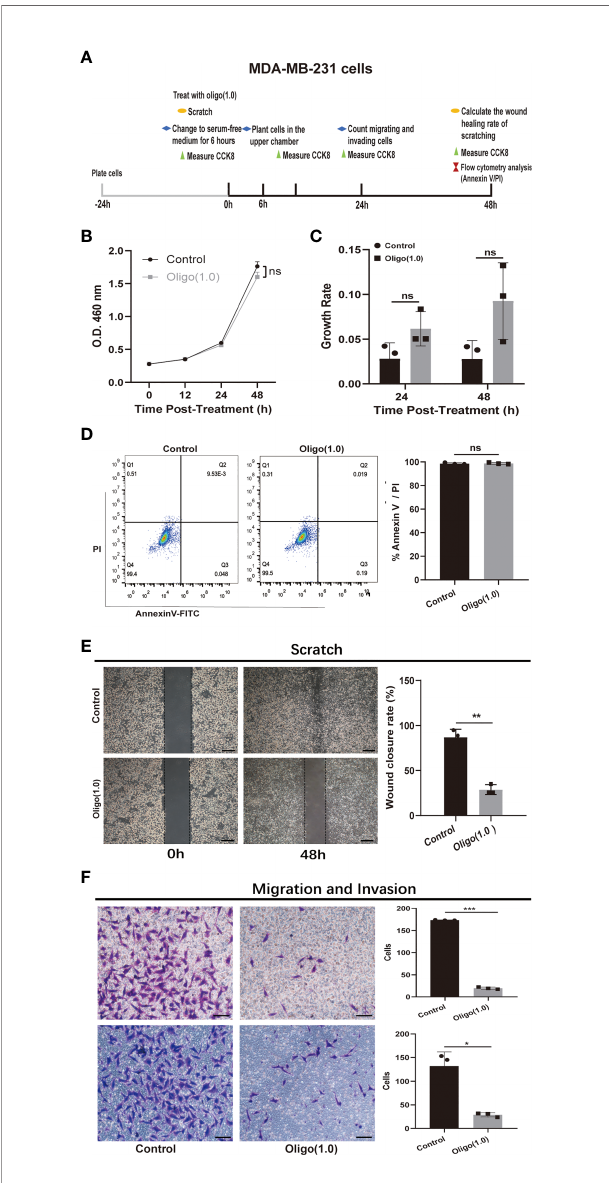
FIGURE 6 | In vitro experiments con fi rmed that OXPHOS plays an important role in breast cancer metastases. (A) Schematic diagram of experimental plan for determining the effect of oligomycin treatment on MDA-MB-231 cells. Oligo(1.0) = 1 m M oligomycin. (B, C) The effect of Oligo(1.0) on the proliferation and growth rate of MDA-MB-231 cells measured by CCK8. The calculation method of growth rate was as follows: Growth rate of Control = ABS(OD value of Control – mean(OD value of Control group)) / mean(OD value of Control group), Growth rate of Oligo(1.0) = ABS(OD value of Oligo (1.0) - mean(OD value of Control group)) / mean(OD value of Control group). (D) Representative images of fl ow cytometry analysis of MDA-MB-231 cells treated with Oligo(1.0) after 48h. (E) Representative images of 48h wound healing rate of scratched wounds of MDA-MB-231 cells treated with Oligo (1.0). Scale bars = 200um. (F) Representative images of 24h migrating and invasion results of MDA-MB-231 cells treated with Oligo(1.0). Scale bars = 50 um. *P < 0.05, **P < 0.01, ***P < 0.001, ns not signi fi cant, P values determined by unpaired two-sided Student ’ s t-test. The data is expressed as the mean ± sd for n =3